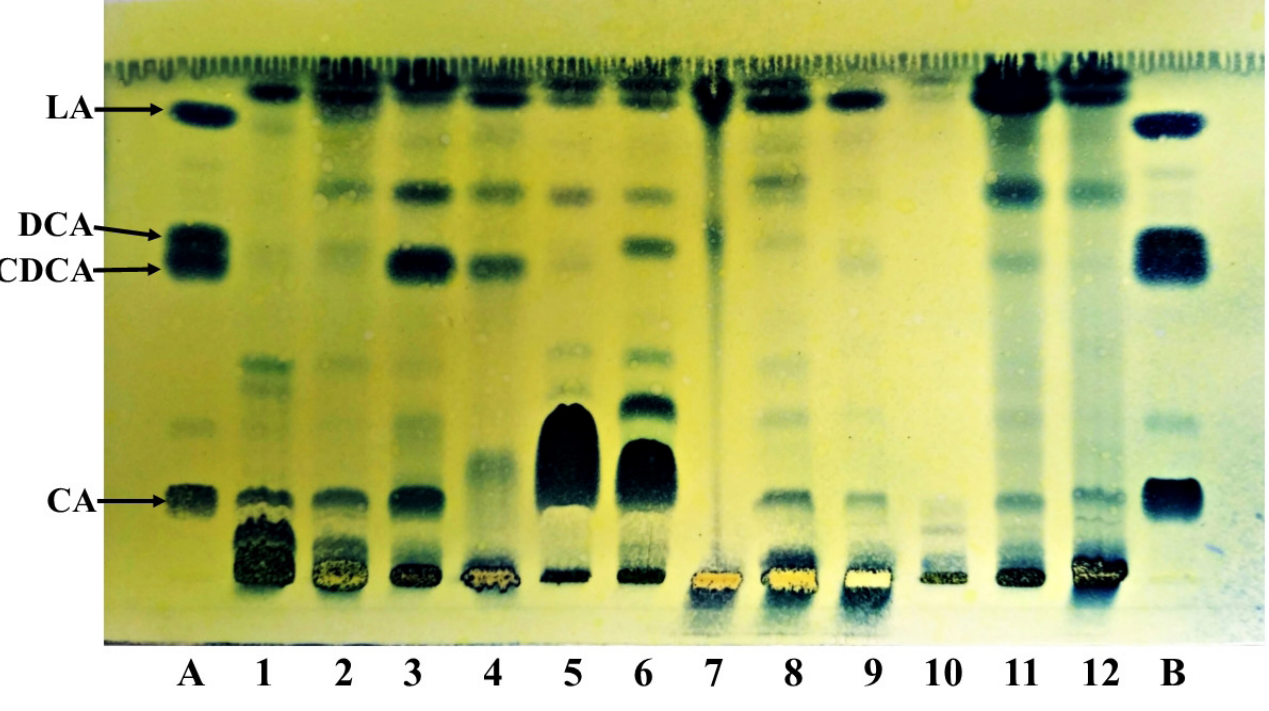
FIGURE 4 - TLC profile of biliary BAs from the selected animals. Standards of CA, CDCA, DCA and LA were set to be 1 mg/ mL (A) and 2.5 mg/mL (B). Samples of 1 to 12 were cow, sheep, chicken, duck, red tilapia, gourami, common carp, striped snakehead, catfish, pangasius, pom-fret, orange-spotted grouper, respectively. Concentrations of samples were 25 mg/mL (3, 5, 6), 50 mg/mL (1, 2, 4, 7, 11), and 75 mg/mL (8, 9, 10, 12). Both standards and samples were dissolved in methanol and spotted for 10 µL onto silica plates with the help of Linomat